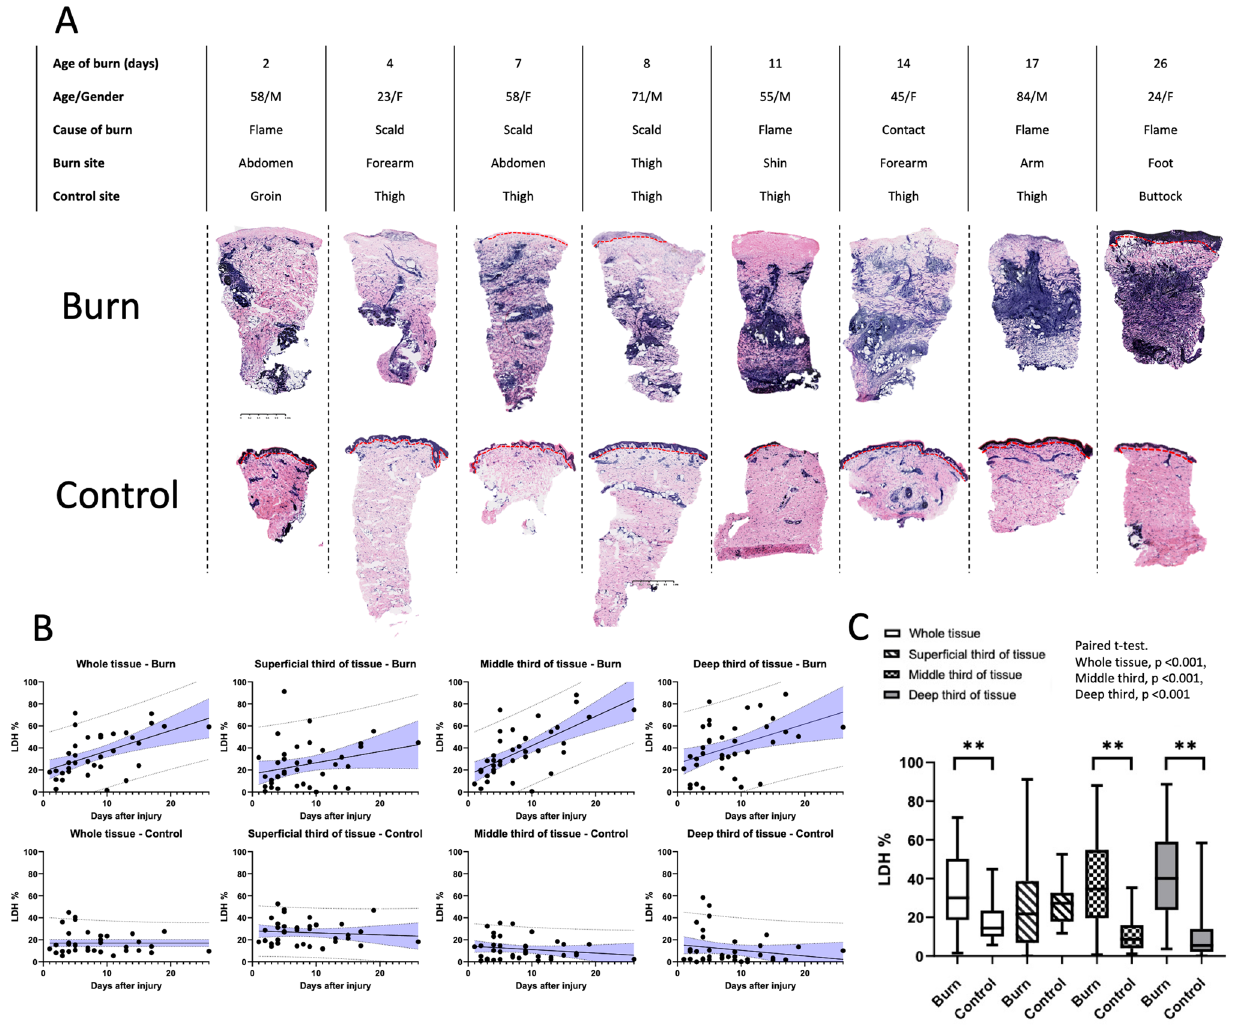
Figure 2. ( A ) Example images of changing LDH staining distribution of burns of older age compared against matched control skin. Demographics of patient, injury type, time since injury and body part section taaken from presented in table. Note the increasing extent of LDH staining (purple) in middle and lower depths of tissue in burn tissue with time since injury and non-linear pattern of this staining. In control skin, more typical pattern of staining is seen as described in Fig. 1(A). Red dotted line indicates epidermo-dermal junction. Note the absence of epidermal cells in 5/8 of the burn sections. ( B ) Time since injury and relationship with LDH stain percentage across whole tissue, superficial, middle and deep third burn vs. control skin is presented. Linear regression line of best fit is presented with 95% confidence interval, 95% prediction limits visualised. See supporting information 4, Table 2 for summary table showing slope, proportion of variance explained by the regression line (R 2 ) together and p value, which accompanies Fig. 2B. ( C ) Box and whisker plot demonstrating average LDH percentage (median, IQR and range) for burn vs. control across whole tissue, superficial third, middle third and deep third of tissue is shown in ( D ) (n = 38, paired t test). **indicates p value of <